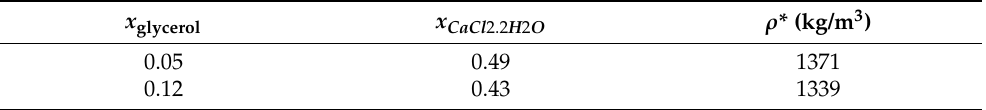
Table 5. Densities of aqueous solutions of glycerol and calcium chloride dihydrate and the respective deviation at θ = 292.15 K measured using a ROTA-Yokogawa Coriolis flow meter. x glycerol x CaCl 2.2 H 2